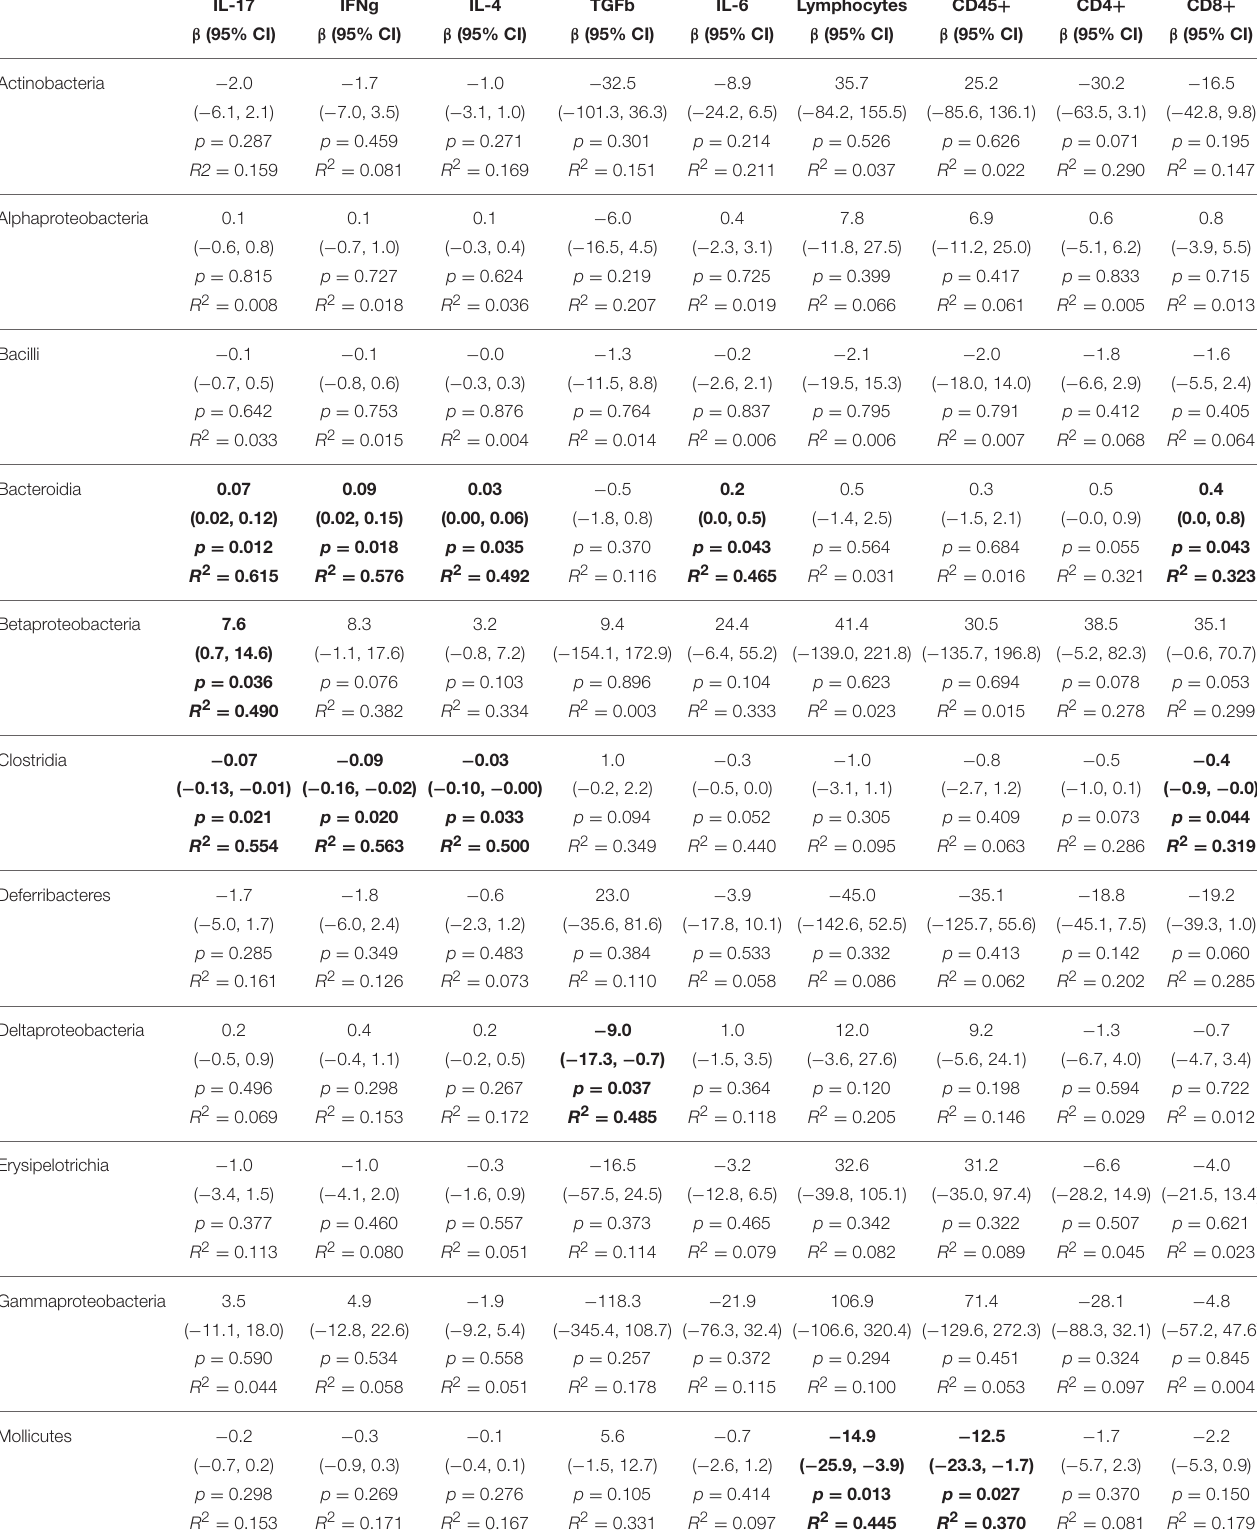
TABLE 1 | Associations from linear models between gut microbiota and alterations of adaptive immune system parameters measured in the